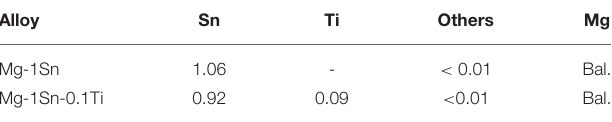
TABLE 1 | Chemical compositions of as-extruded alloys (wt.%). Alloy Sn Ti